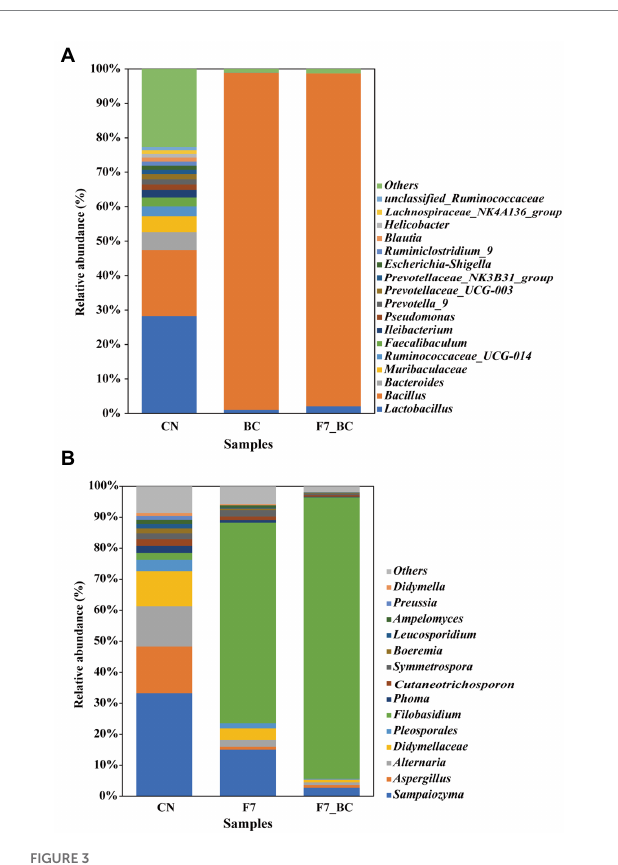
FIGURE 3 Analysis of bacterial (A) and fungal (B)